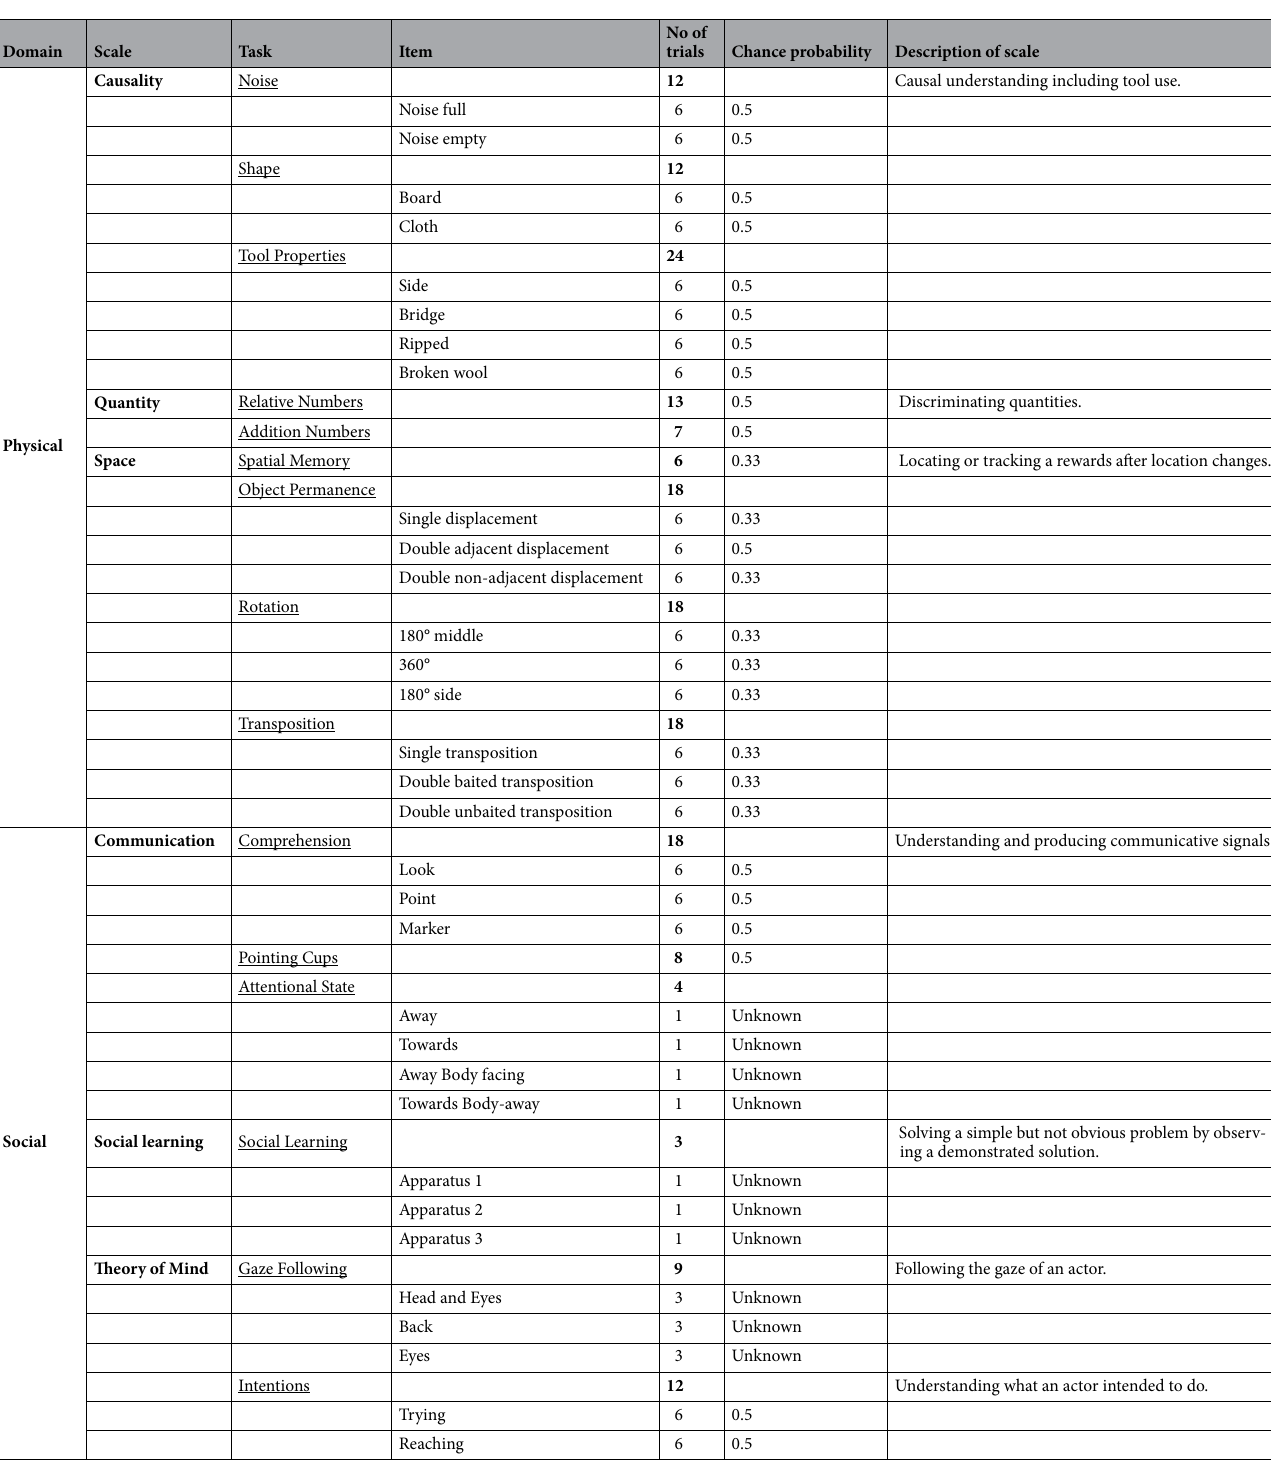
Table 1 Overview of the Corvid Cognition Test Battery. Table 1 provides an overview of the Corvid Cognition Test Battery as a function of domain, scale, task, item, number of trials, chance probability, and description of scale. Numbers in bold depict the number of trials carried out per task. Note: Some parts of the table are taken from Herrmann and colleagues 4